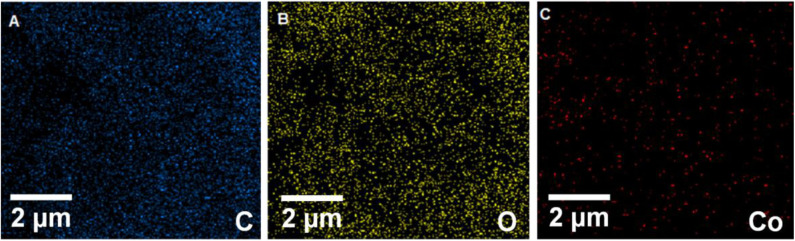
EDX elemental mapping of (A) carbon, (B) oxygen, and (C) cobalt in G/Co3O4 nanocomposite.